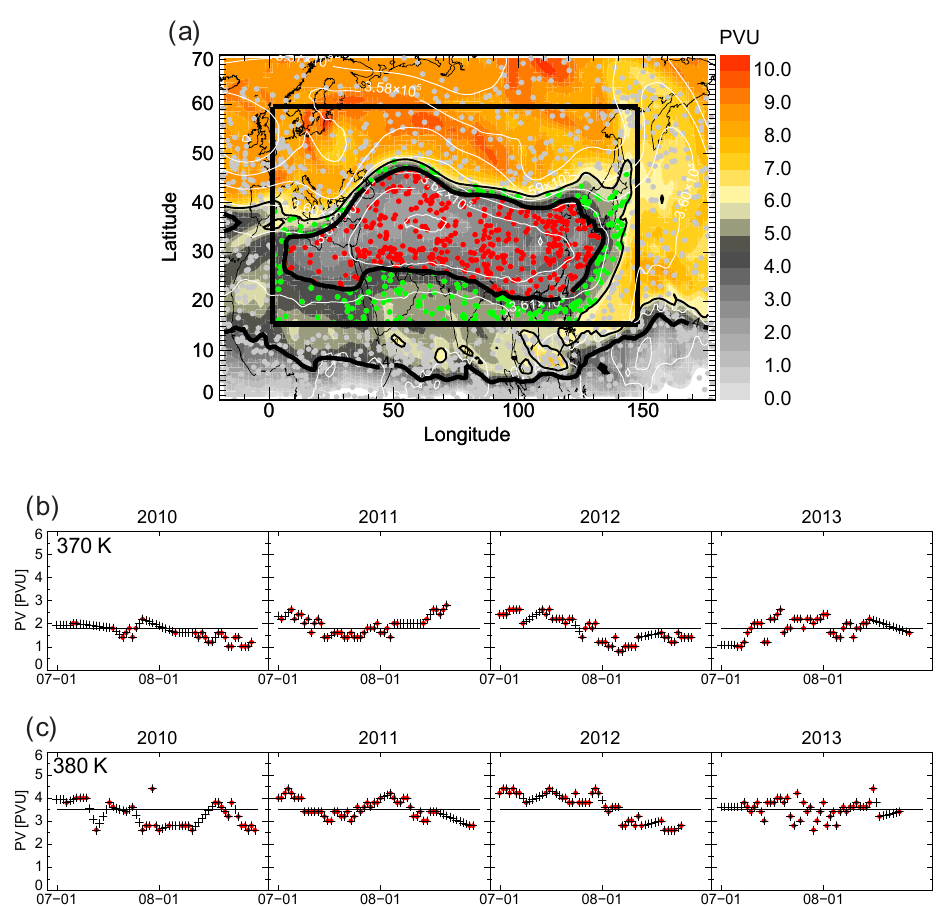
Figure 6. (a) Map of time-averaged PV field at 380K on 6 July 2011, calculated as the average over the PV distribution for 5–7 July 2011. The thick black contour shows the calculated PV-gradient-based anticyclone border PV ∗ (4PVU for that date), and the thin black contour shows PV ∗ + 2PVU. Thin white contours show selected Montgomery stream function values. Filled circles show CLaMS air parcels between 379 and 380K, with parcels inside the anticyclone core colored red and those at the anticyclone edge colored green. The black rectangle indicates the regional restriction of the calculation (see text). (b) Time series of PV-gradient-based anticyclone border PV value at 370K, with the calculated barrier as red circles and interpolated barrier (at days where the calculation did not work, interpolated from existing neighbor values) as black crosses. (c) Same as (b) but for